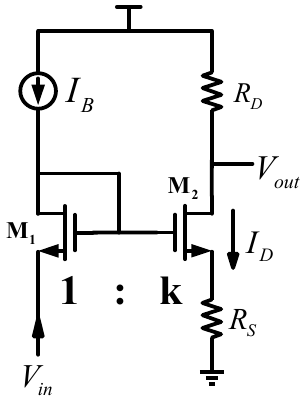
Figure 3. Equivalent model of the transconductance cell G m .